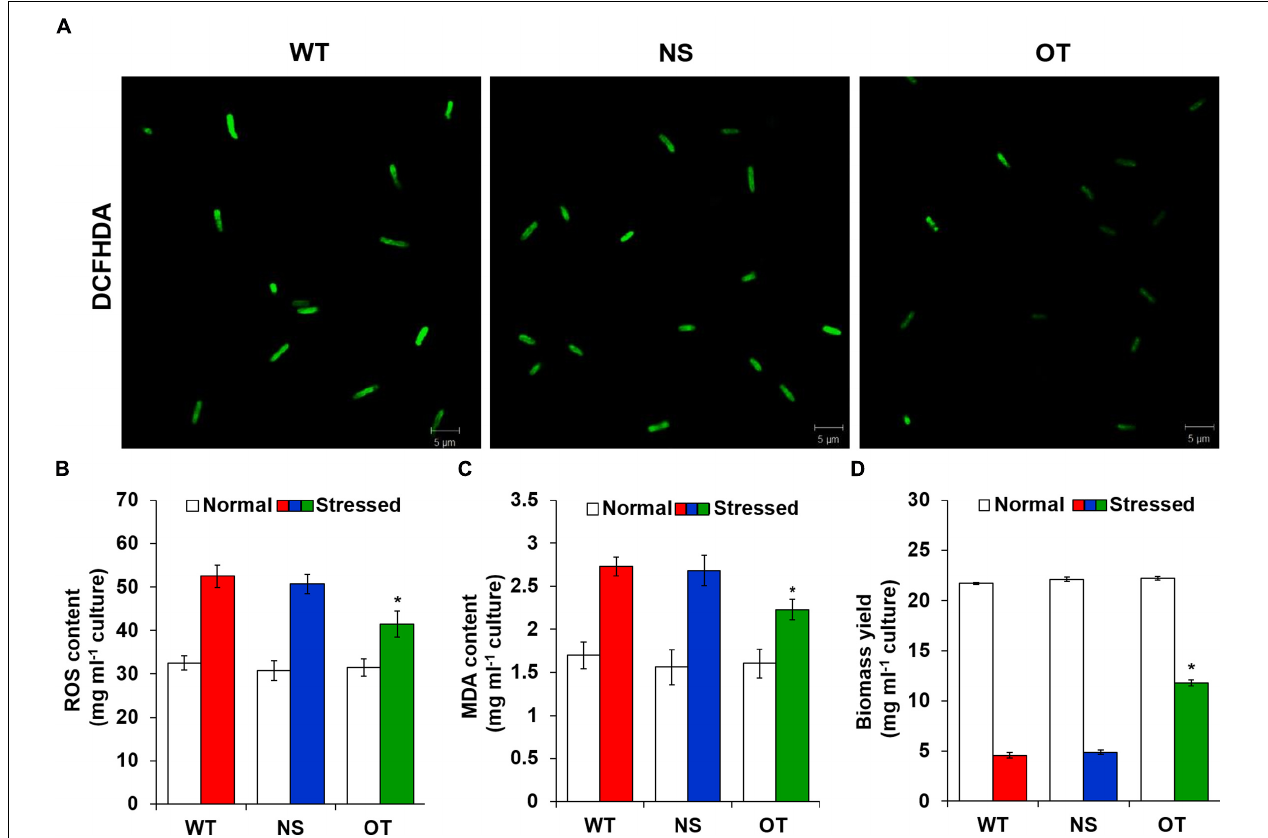
FIGURE 5 | Measure ROS, MDA levels and dry weight under the oxidative stress. (A) Detection of DCFHDA fluorescence using confocal microscopy. (B) Intracellular ROS levels determined by FOX reagent. (C) The level of lipid peroxidation determined by MDA using a TBA assay. (D) Biomass yield measured after growth in the presence of high H 2 O 2 concentrations. Error bars indicate SD of three independent experiments. Error bars indicate ± SD of three independent experiments. Asterisks indicate significant differences between treatments as estimated by Student’s t -test ( P <